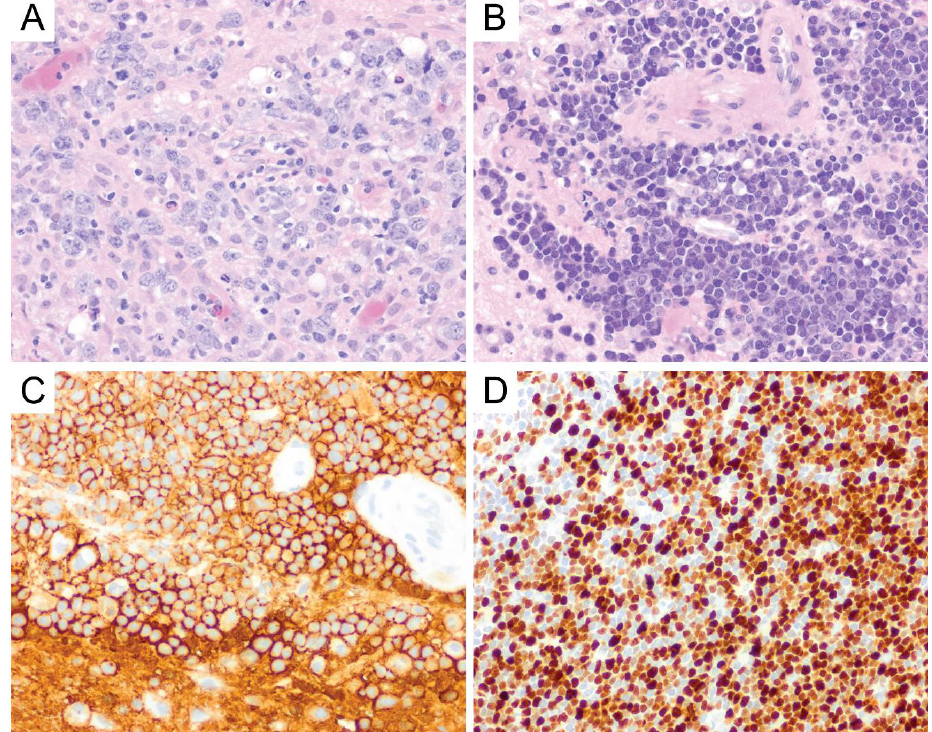
Figure 4. Primary CNS DLBCL. Lymphoma cells are round to oval and contain irregular, vesicular nuclei with prominent nucleoli, morphologically consistent with centroblasts or immunoblasts ( A , original magnification ×400). Primary CNS DLBCL usually shows perivascular arrangement (angiocentricity) with tumor cells forming layers around the blood vessels ( B , original magnification ×400). They express CD20 ( C , original magnification ×400) and usually show a high Ki-67 proliferation index ( D , original magnification ×400).